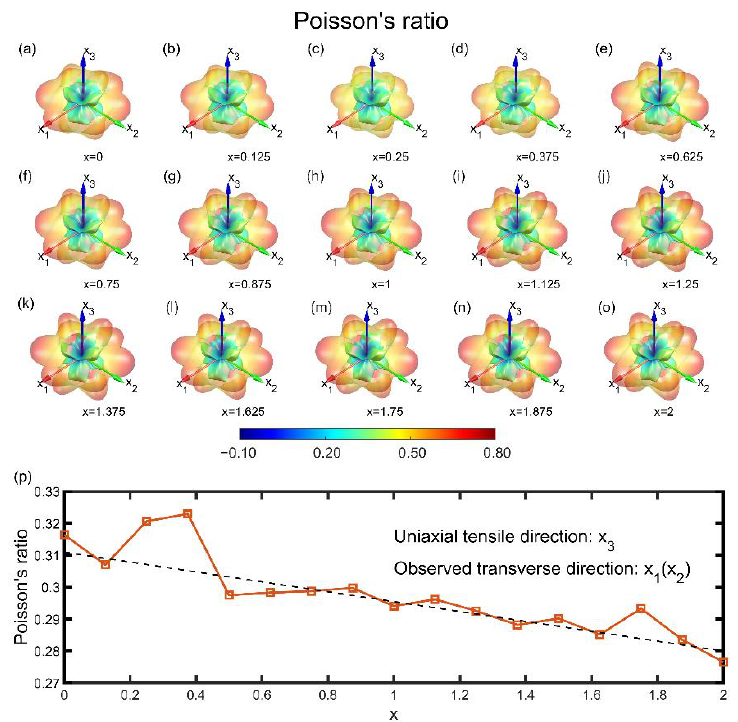
Figure 4. Poisson’s ratio distribution at various Sb contents. ( a – o ) Direction-dependent shear modulus at different Sb content x at an interval of 0.125, ranging from 0 to 2. Outer surface denotes the maximum Poisson’s ratio, and inner surface is on the contrary. ( p ) Poisson’s ratio of the tensile direction along x 3 and observed transverse direction along x 1 or x 2 varies with respect to the Sb content x. A linear dependency can be viewed (dashed